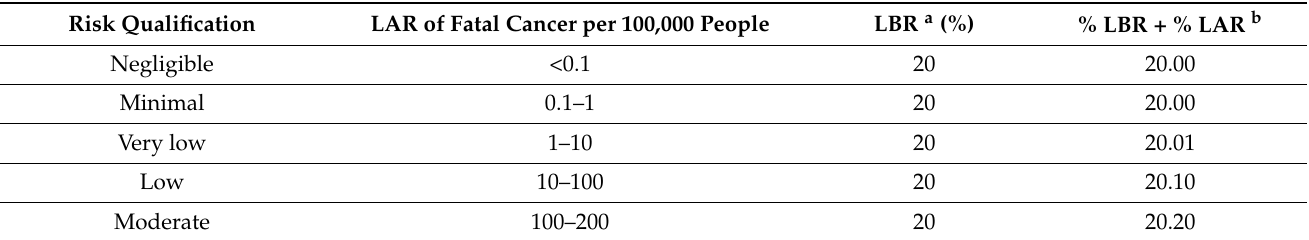
Table 2. A qualitative approach to communicate different levels of cancer mortality associated with radiation exposure compared with the lifetime baseline risk of cancer